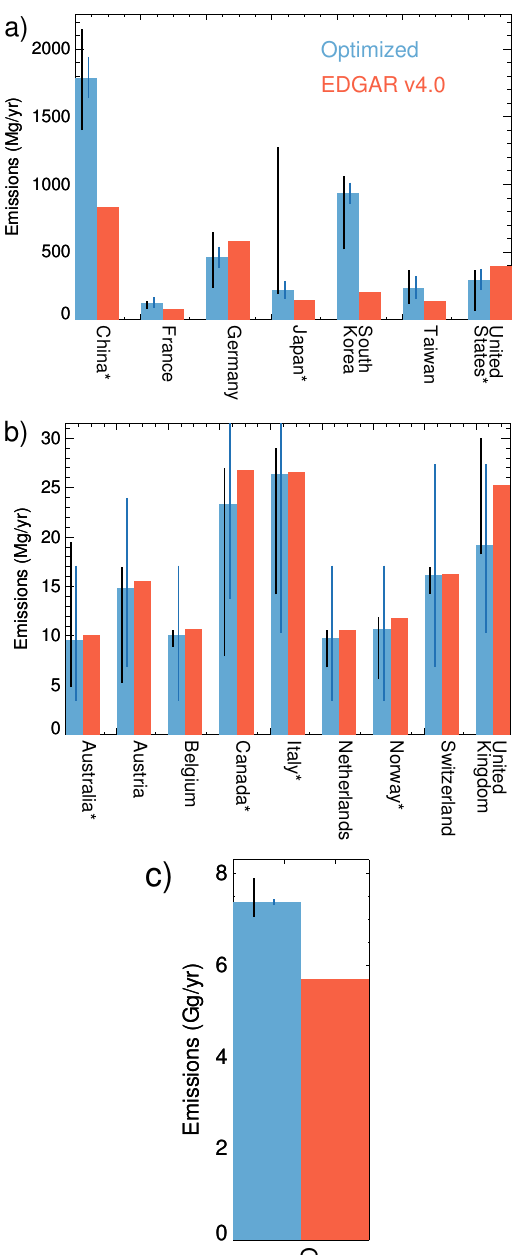
Fig. 7. Optimized 2007–2009 average emissions (blue bars) and EDGAR v4.0 2005 emissions (red bars) for: (a) countries with large emissions within “local” regions; (b) countries with smaller emis- sions within “local” regions; (c) global totals. The blue error bars show the 16th to 84th percentile ranges for the posterior distribu- tion and black error bars show the range of average emission rates, obtained in the different inversions performed in Sect. 3. Aster- isks indicate countries that do not entirely reside within the local regions. The emissions shown for these countries are a fraction of the national total